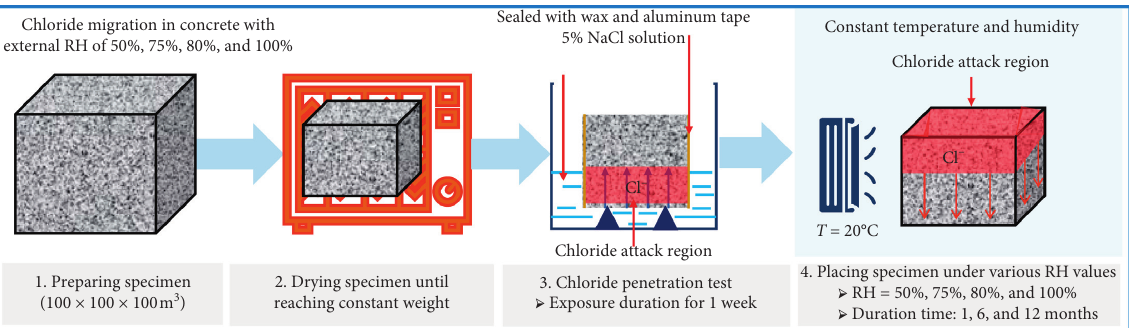
Figure 2: Experiment flow for chloride penetration into concrete exposed to various external RH values.